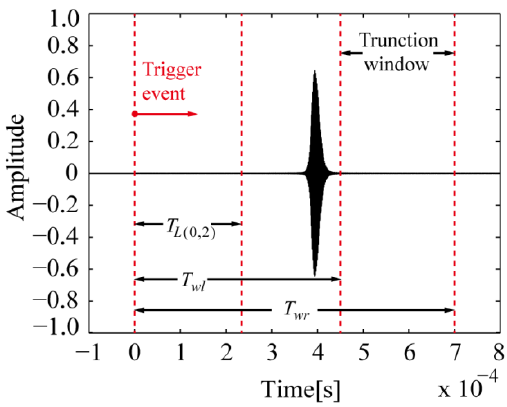
Figure 6. Truncation window for defect scatter signals extraction.